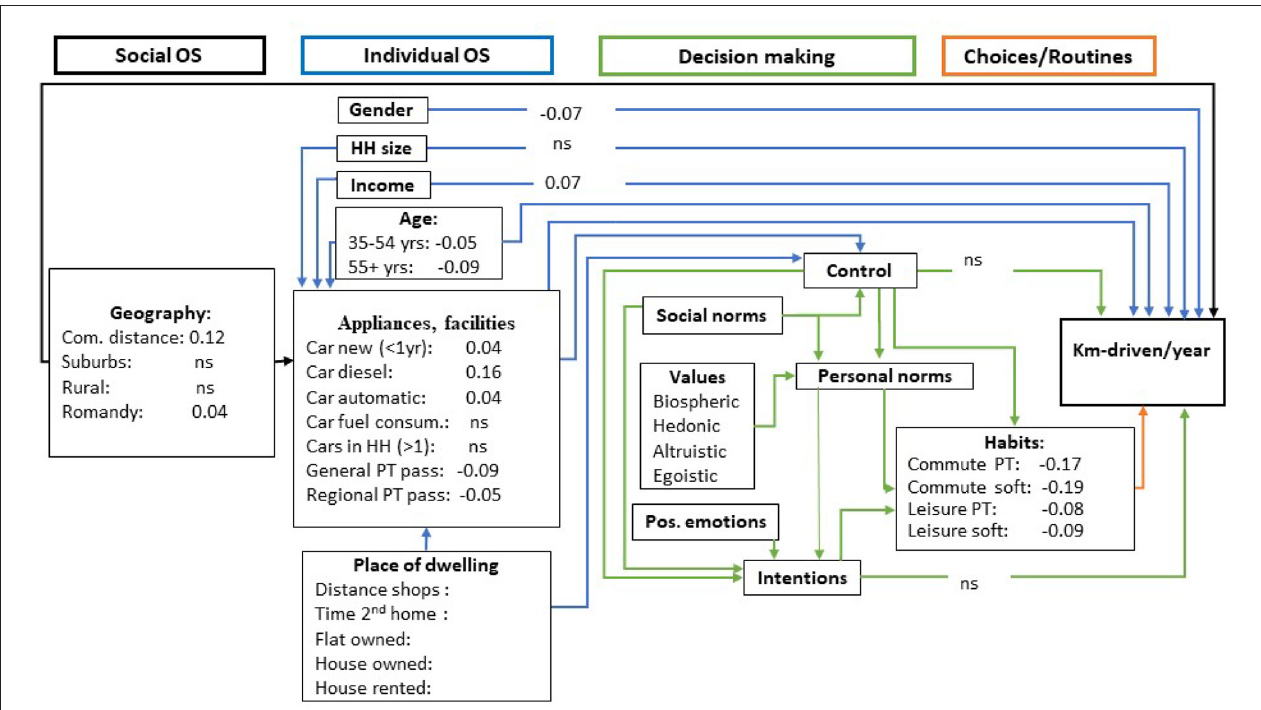
FIGURE 4 | Direct pathways explaining km-driven/year. The arrow colors depict the four different components of the empirical model. Reported are standardized coefficients of direct effects with p < 5% (complete results are provided in Table A5 ), ns = not significant at 5%; PT = public transport; soft = soft mobility; fuel consum. = fuel